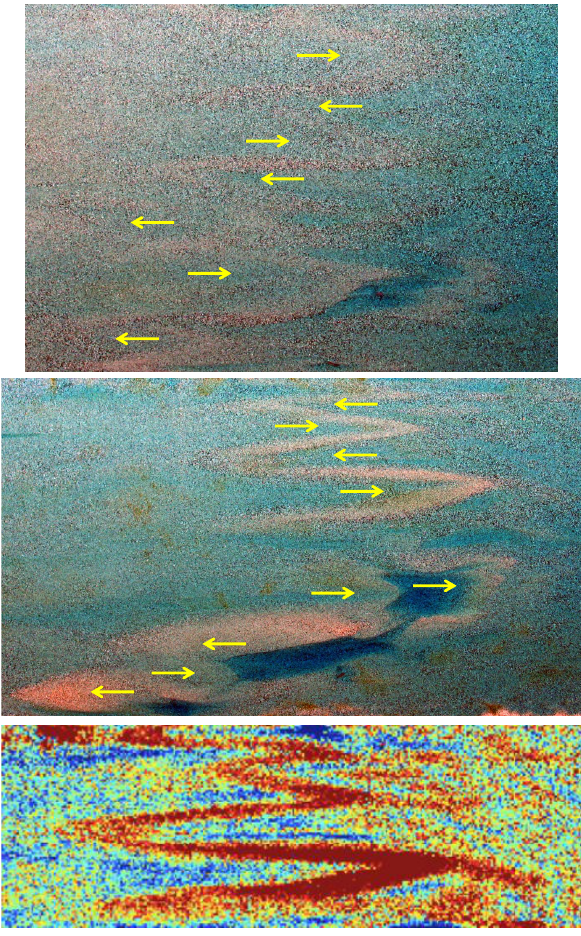
Fig. 2. Top view on V-shaped tidal bars early and late in low-energy experiment 1 after about 100 and 1000 tidal cycles. Blue colour indicates water depth and arrows indicate dominant tidal flow di- rection. Bottom panel shows DEM of V-shaped bars with red and blue colours 1.5mm above and below initial bed